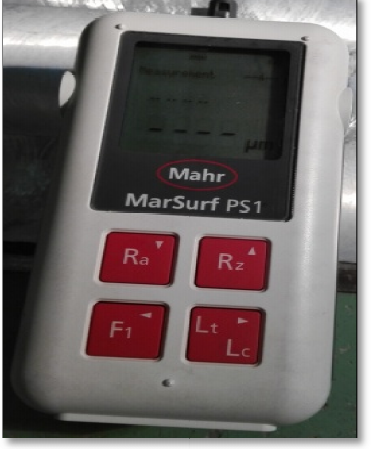
Fig. 3. Roughness device (Marsurfps1).